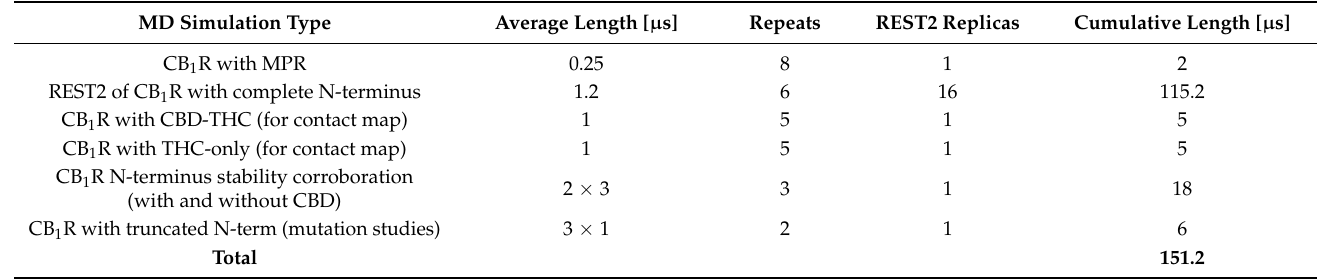
Table 1. The MD simulations performed in this